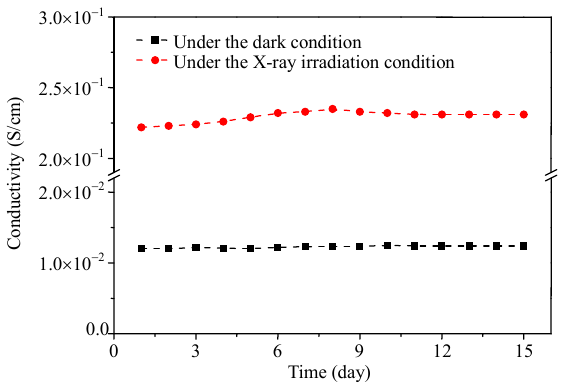
Fig. 7 Variation of conductivity of the un-annealed film against